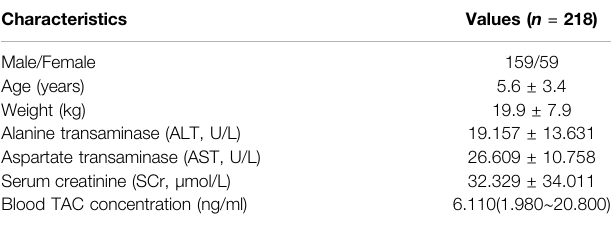
TABLE 1 | Demographics and main clinical characteristics of all pediatric patients with refractory nephrotic syndrome.